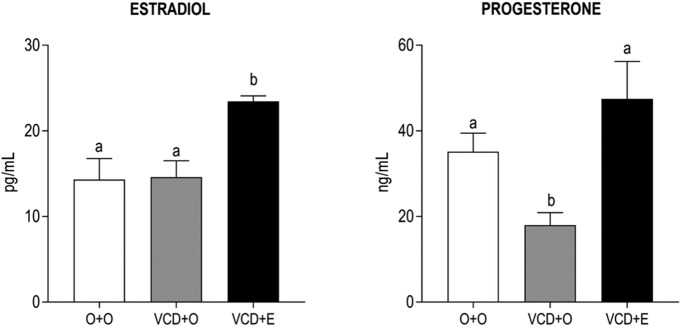
Effects of follicular depletion induced by VCD and chronic 17β-estradiol (E) treatment on estradiol (left panel) and progesterone (right panel) plasma concentrations. Female rats at 28 d of age were subcutaneously injected with corn oil (O) or VCD for 15 consecutive days. Fifty-five days after the first injection of VCD/oil, rats received a subcutaneous capsule that contained corn oil (groups O + O and VCD + O) or 17β-estradiol (VCD + E). Rats were decapitated during the diestrous phase (O + O and VCD + O groups) or 21 d after the onset of E therapy (VCD + E), from 75 to 85 d after the onset of VCD/oil administration, between 9:00 and 11:00 A.M. Data are presented as the mean ± SEM. Significance was defined as p < 0.05. Different letters indicate significant differences (n = 6-9).